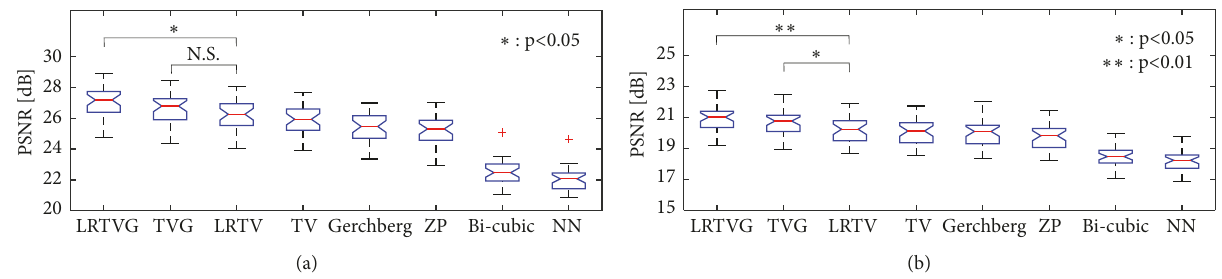
Figure 8: Box-plots of the PSNR results obtained using different methods with 37 images from OASIS. The proposed method (LRTVG and TVG) performed better than the other methods. (a) 𝛽 = 6 , (b) 𝛽 = 12